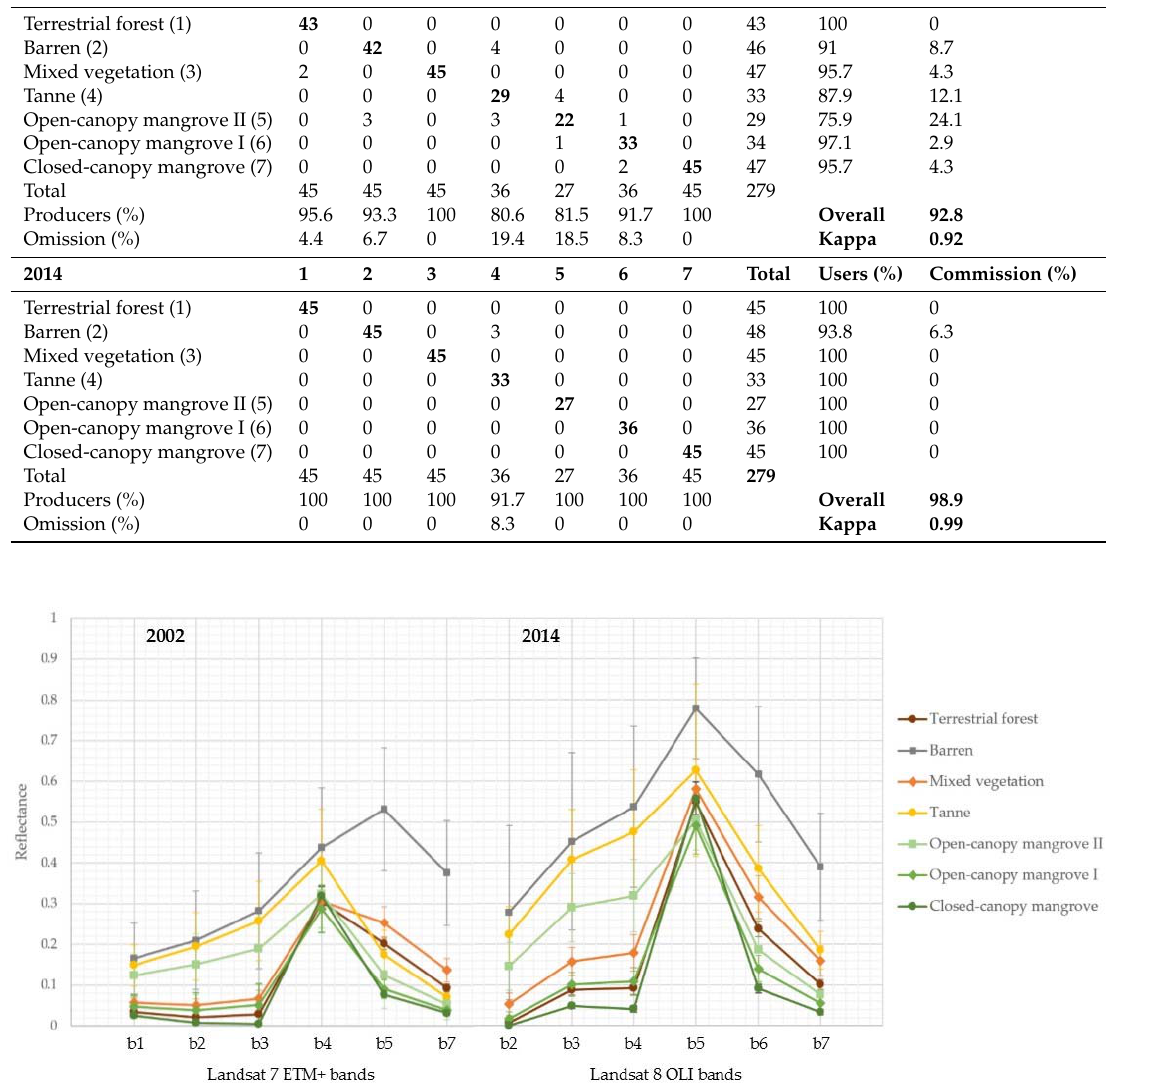
Figure 8. The spectral signatures extracted from the calibration areas for each class from the 2002 and 2014 Landsat images.